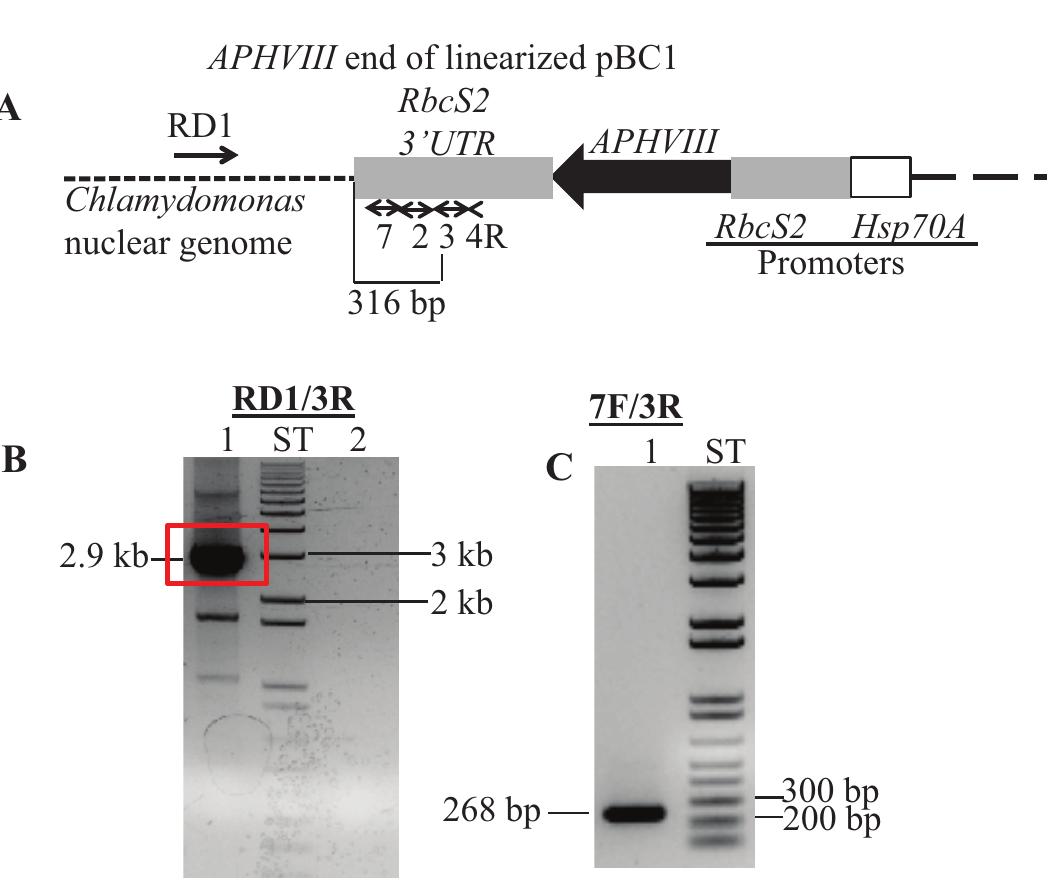
Figure S2. Locating the APHVIII flanking genomic sequence in 6F14 . ( A ) A diagram showing a truncated pBC1 illustrating the APHVIII end of the linearized pBC1 vector. Primers used for PCR and DNA sequencing are shown by numbered black arrows. Thermal Asymmetric InterLaced1 (TAIL1) PCR was performed using primers 4R and RD1 (a random degenerate primer). ( B ) TAIL2 PCR was performed using primers 3R and RD1. In lane 1, 10-fold diluted TAIL1 PCR product was used for TAIL2 PCR; Lane 2 is a zero DNA control lane. The 2.9 kb TAIL2 PCR product used for DNA sequencing is highlighted in the red box. Initial DNA sequencing was performed using vector specific primers 2R and 3R (Table 1). ( C ) Gel purified DNA product (2.9 kb) from TAIL2 PCR was used to verify if the product is specific to the APHVIII gene. PCR primer names are labeled on the top of the gel. PCR product size is labeled. F and R stand for forward and reverse primers, respectively. All primer sequences are shown in Table 1. ST stands for 1 kb plus ladder (Invitrogen, Carlsbad, CA). DNA samples were run on a 1% agarose